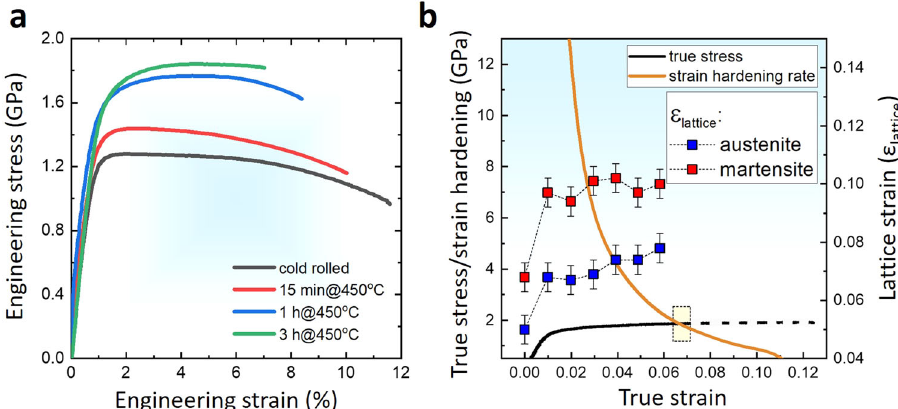
Fig. 4 Mechanical performance and behavior. a Tensile curves of the Fe18Mn3Ti alloy cold rolled and annealed up to 3 h at 450 °C. b in situ synchrotron XRD analysis of the Fe18Mn3Ti alloy cold rolled and annealed during 1 h at 450 °C showing the evolution of the lattice strain in the martensitic and austenitic phases during tensile deformation. Error bars represent the precision limit associated with